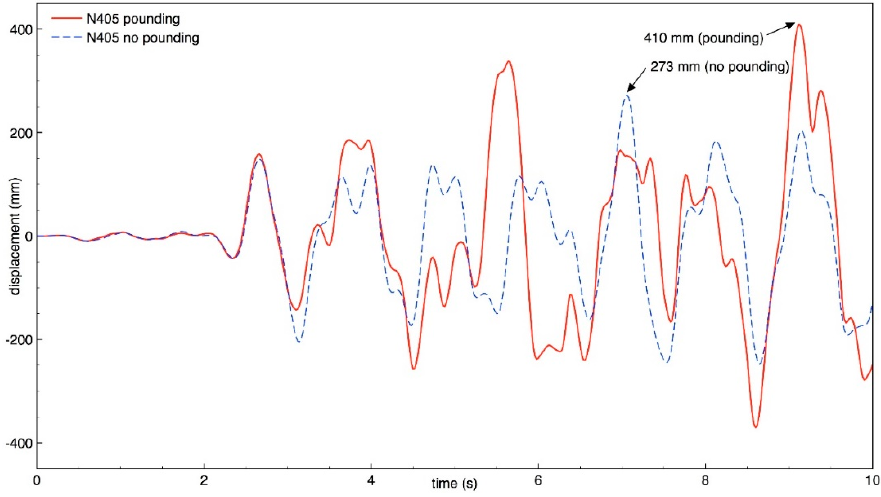
Figure 23. Transverse response of building B (node N405) with and without pounding.